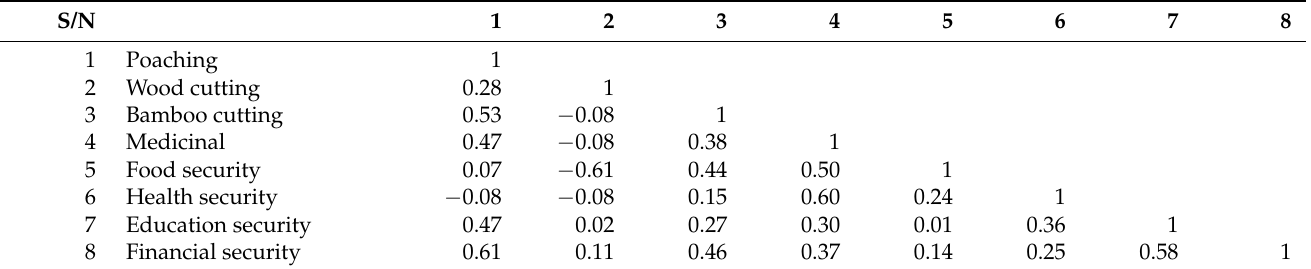
Table 4. Variable Correlations.